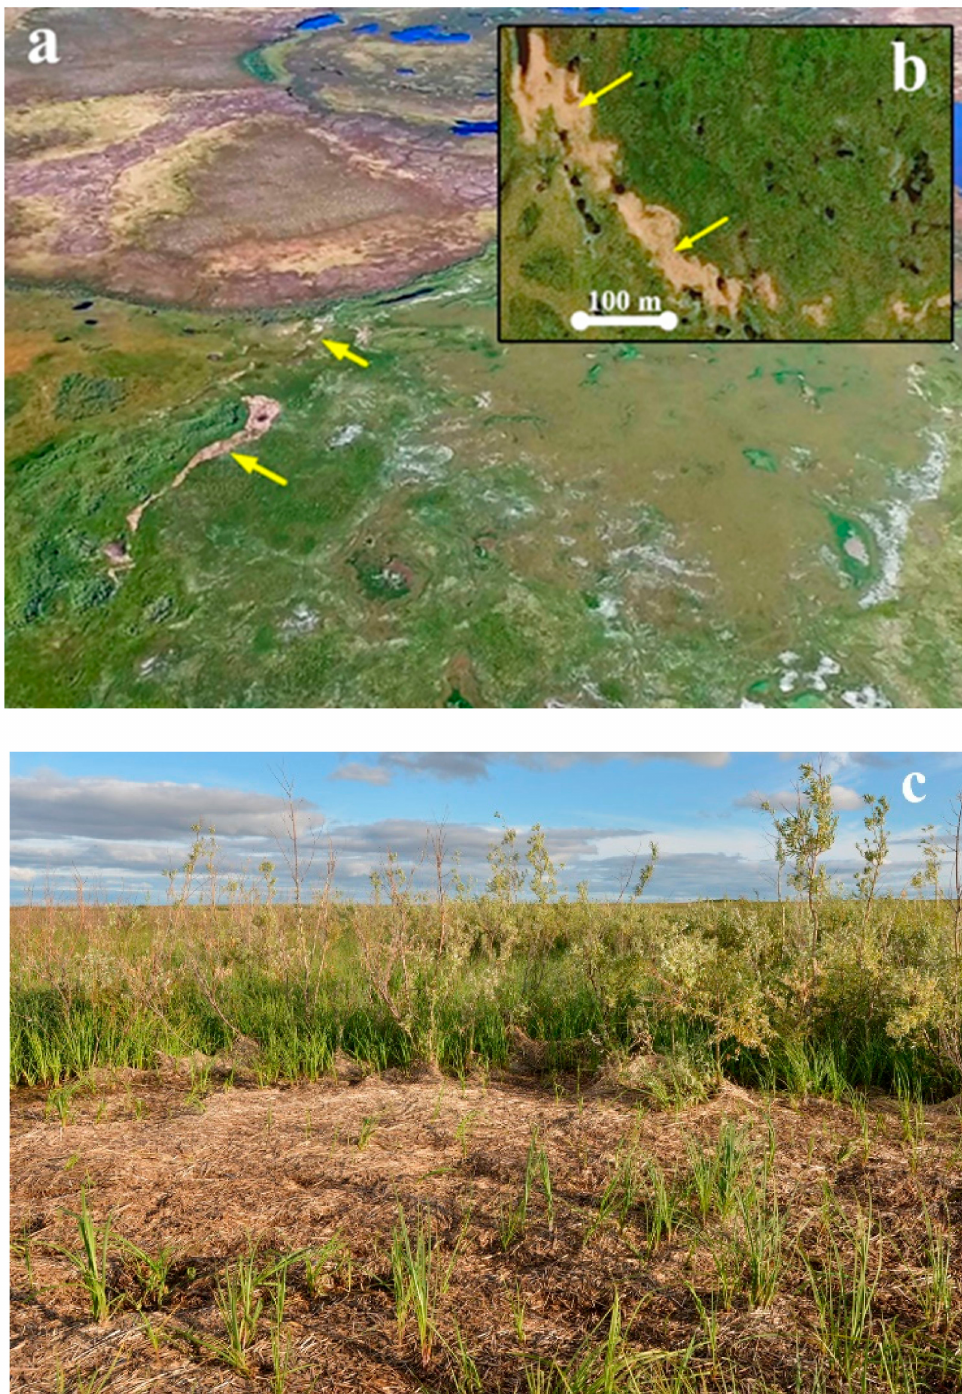
Figure A5. The accumulation of straw A. fulva on the border of the temporary spring reservoir in the khasyrey (breaking accumulation): ( a )—view from the drone in 2016 (yellow arrows); ( b )—a satellite image taken in 2017 (yellow arrows); ( c )— A. fulva straw in a sedge willow (ground photograph,